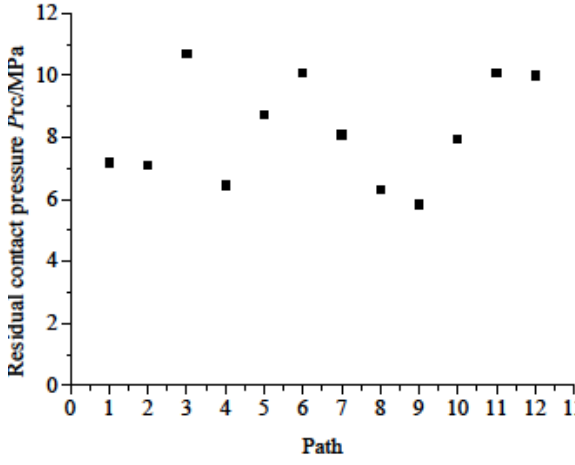
Figure 3: Residual contact pressure between lined tube and base tube